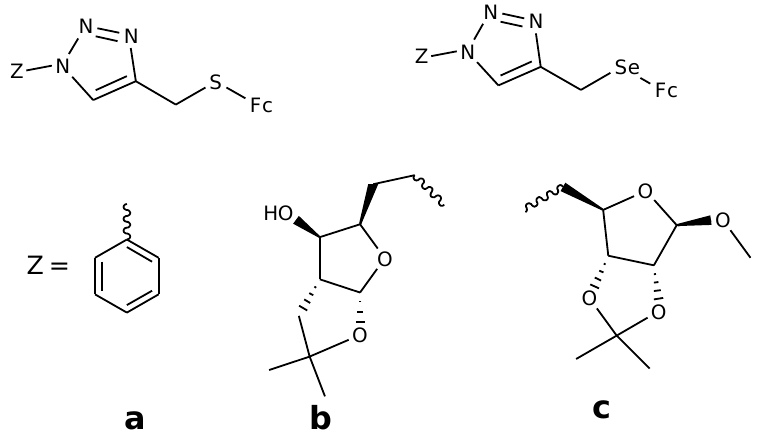
Figure 24. Chemical structures of ferrocenyl – chalcogeno – triazole conjugates ( 70 – 71 ).